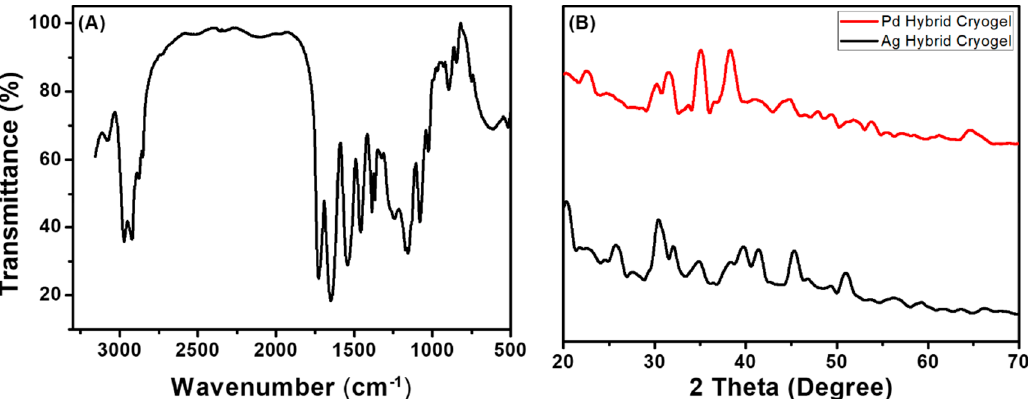
Figure 2. FTIR spectrum of NIPAM-based pure cryogels (CR) ( A ) and XRD spectra of Pd-hybrid Figure 2. ( A ) FTIR spectrum of NIPAM-based pure cryogels (CR) and ( B ) XRD spectra of Pd-hybrid (CR-Pd) and ( B ) Ag-hybrid (CR-Ag) NIPAM-based cryogels. (CR-Pd) and Ag-hybrid (CR-Ag) NIPAM-based cryogels.